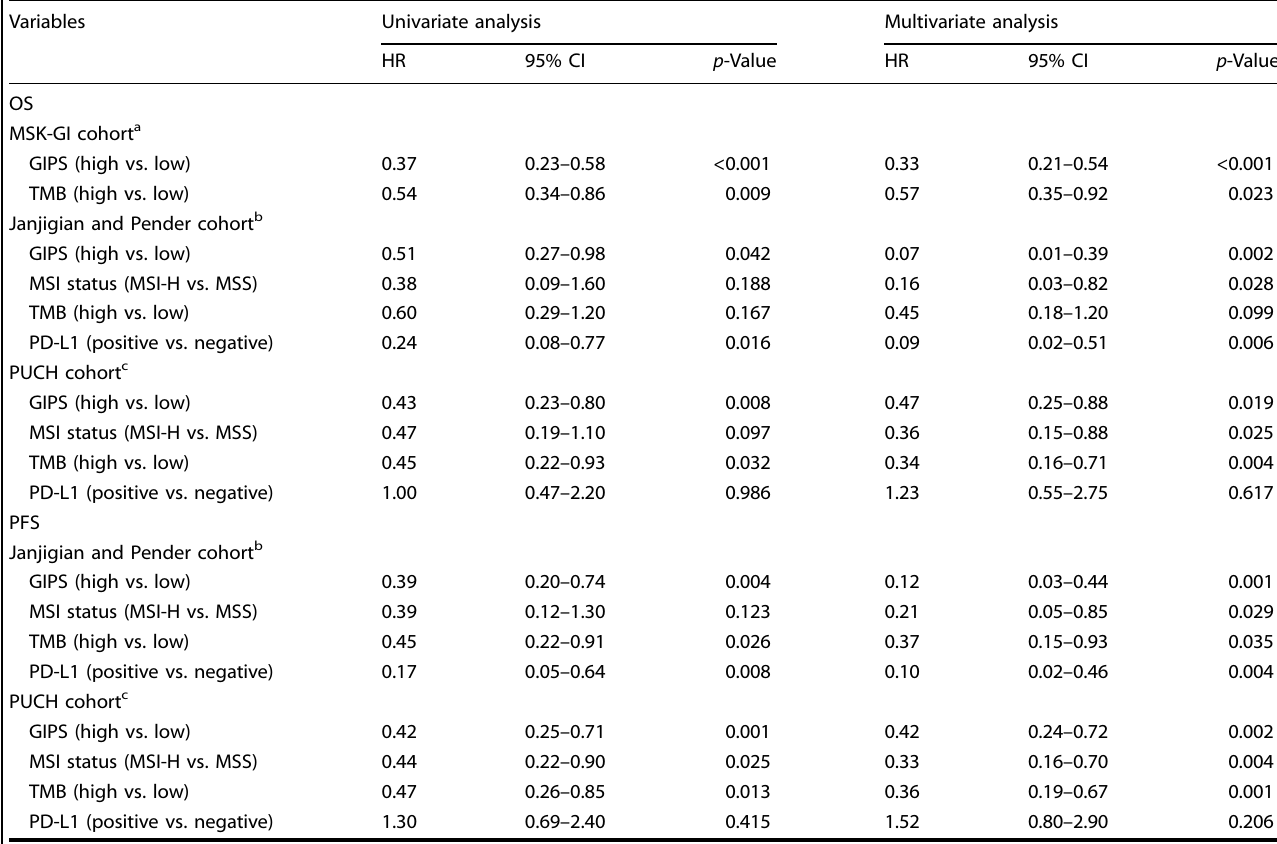
Table 1. Univariate and multivariate Cox analysis for PFS and OS in three cohorts.